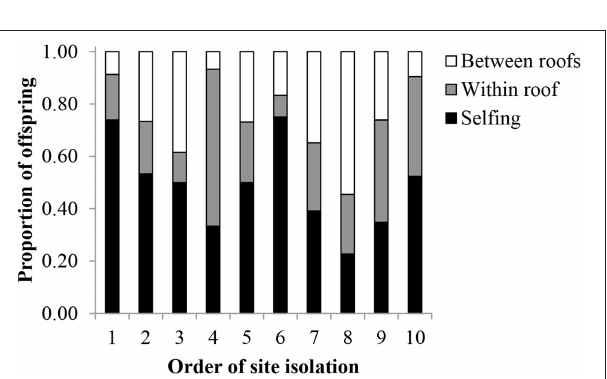
FIGURE 4 | The proportion of P. hirsutus offspring resulting from self-pollination (“selfing,” mean = 48% ± 16 sd), within-roof-pollination (mean = 27% ± 14 sd), and between-roof-pollination (25% ± 14 sd) on 10 green roofs. Populations are ordered from least to most isolated, according to the mean distance to all other roofs included in the